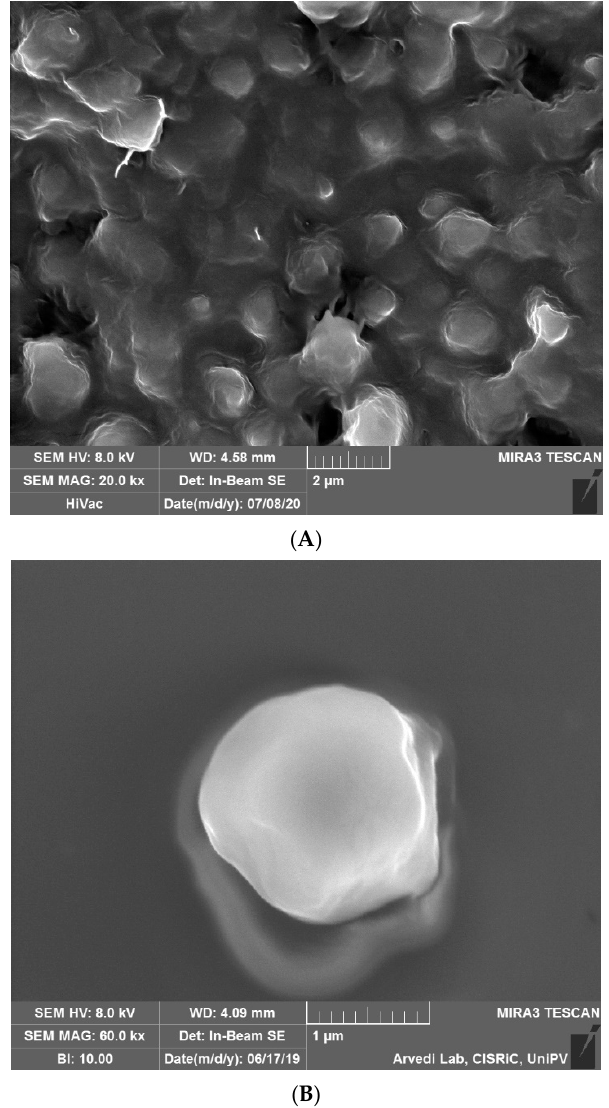
Figure 1. SEM images of ( A ) microstructured lipid carriers (NAC-CH-MLC); ( B ) single particle at higher magnification.